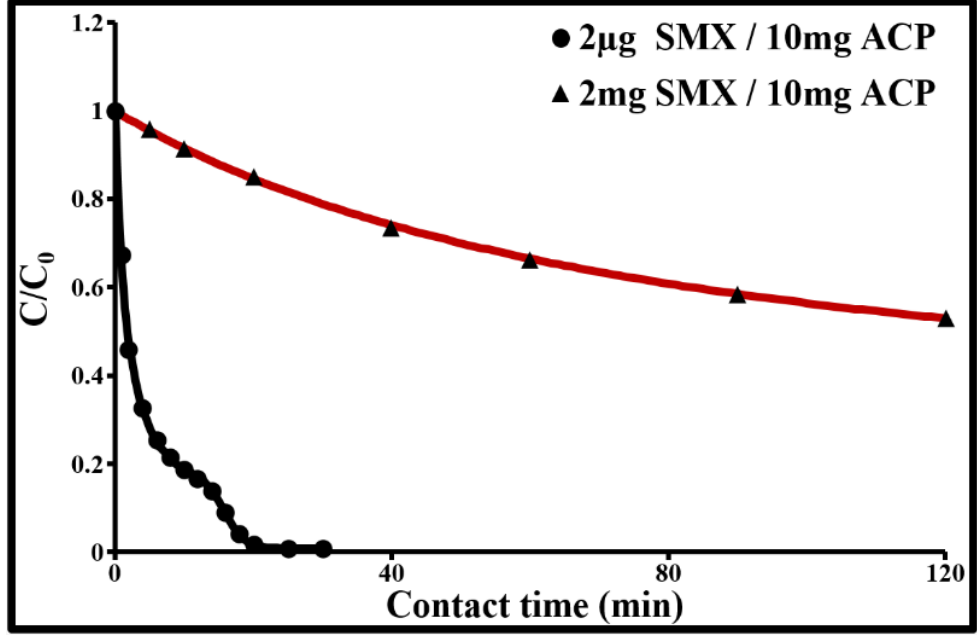
Figure 4. Dimensionless concentration as a function of time for SMX adsorption by ACP in drinking water at 293 K. (Values given at ± 2 ng / L for 2 µ g SMX / 10 mg ACP and at ± 0.03 mg / L for 10 mg SMX/10 mg ACP).